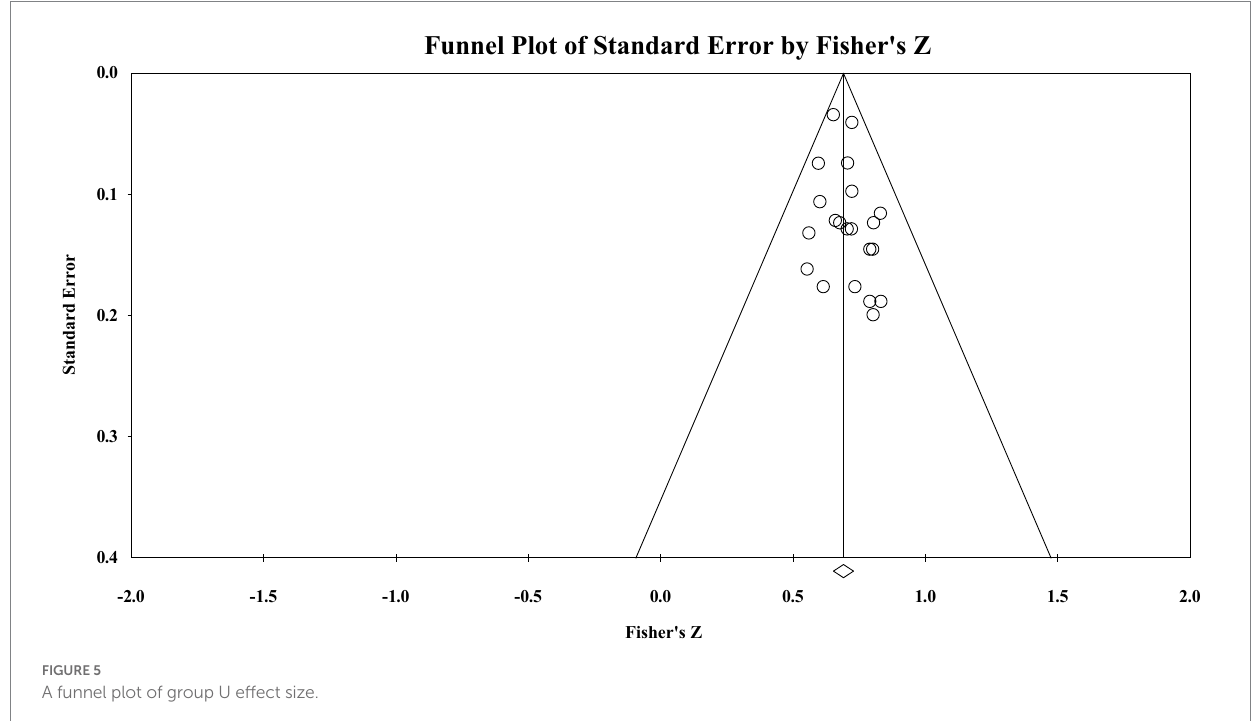
FIGURE 4 A funnel plot of group S effect size.